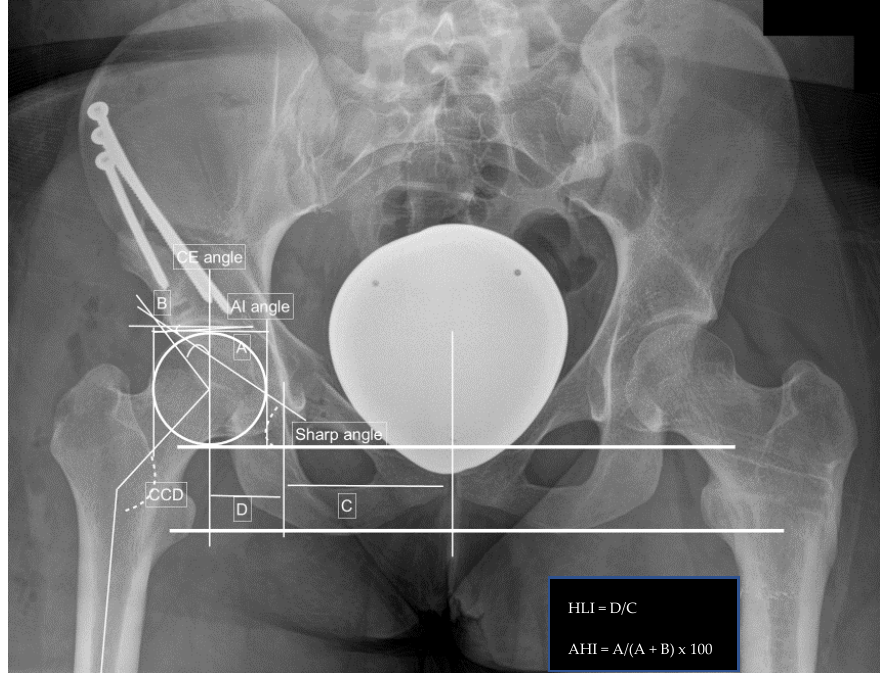
Figure 5. Postoperative measurements after right-sided PAO: CE angle 38.8°, AIA − 5.1°, sharp angle 28.0°, hip lateralization 0.57, anterior hip index 90.3, CCD angle 121.0°, and positive crossing-over sign.